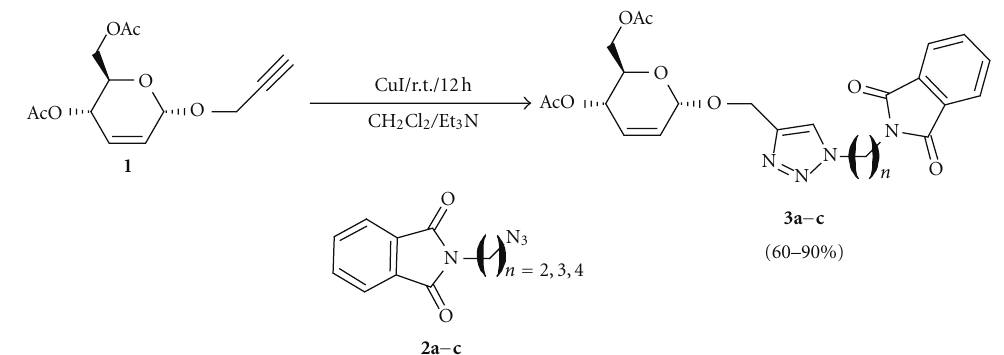
Scheme 1: Synthesis of compounds 3a–c .